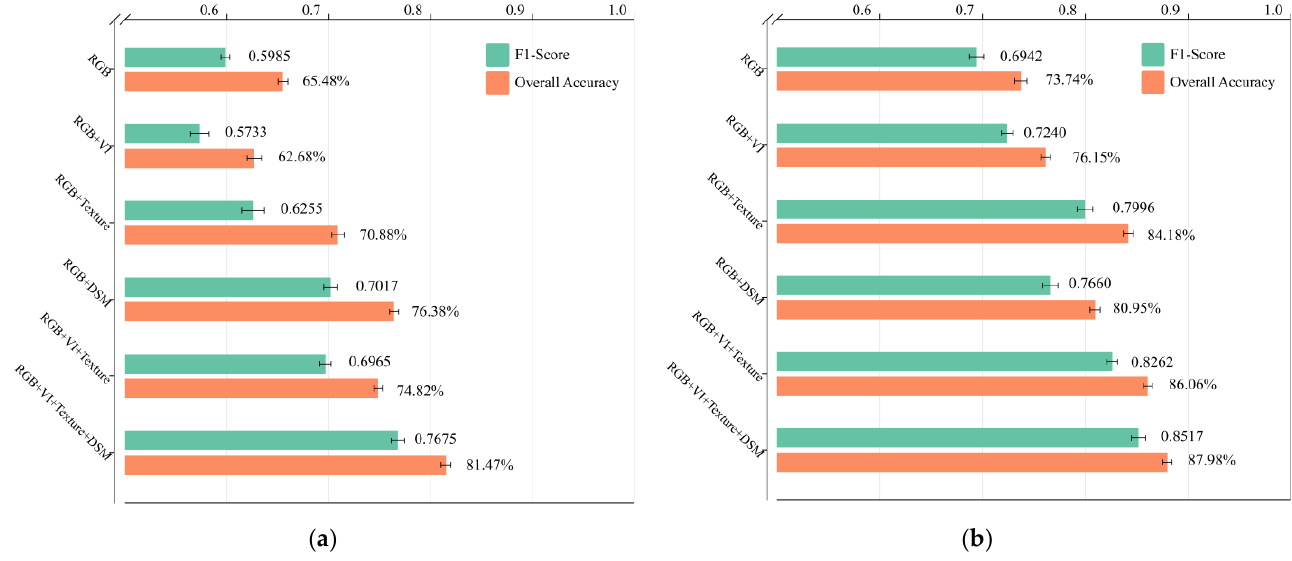
Figure 4. Overall Accuracy and F1-Score for PB and OBIA classification with different feature Engineering ( a ) PB classification; ( b ) OBIA classification. Each experiment was executed 20 times in GEE using training and validation points resampled randomly from the dataset to reduce the uncertainty due to sampling. The values in the figure are the average of 20 replicate experiments, and the error bars are shown in the figure.